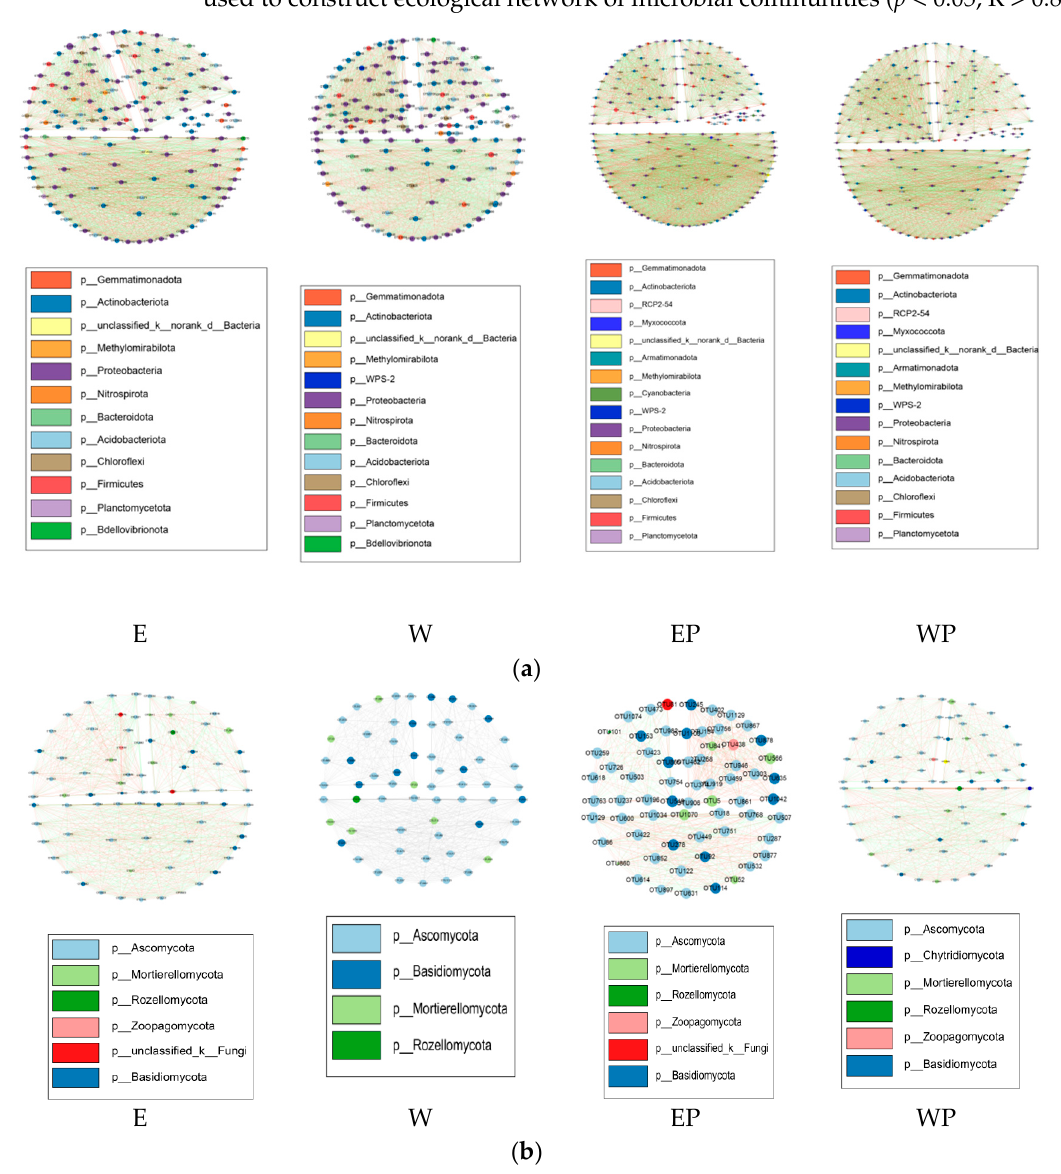
Figure 7. The co-occurrence network of soil bacteria ( a ) and fungi ( b ) in soil samples by applying peanut root exudates or distilled water. E: grapevine replanting soil irrigated with peanut root exudates, W: grapevine replanting soil irrigated with distilled water, EP: rhizosphere soil of grapevine seedling irrigated with peanut root exudates for 28d+24d, WP: rhizosphere soil of grapevine seedling irrigated with distilled water for 28d+24d.